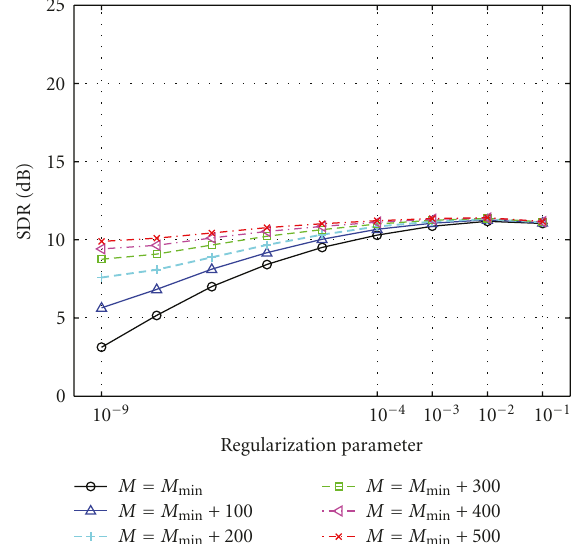
Figure 12: Performance as a function of the regularization parame- ter and additional filter length (modeling delay is fixed at d = 500).